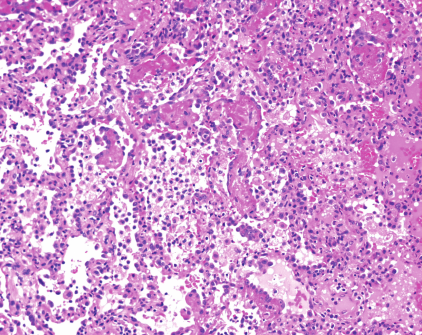
Figure 1: Coronal CT chest demonstrating bilateral perihilar pulmonary infiltrates consistent with di ff use alveolar haemorrhage.